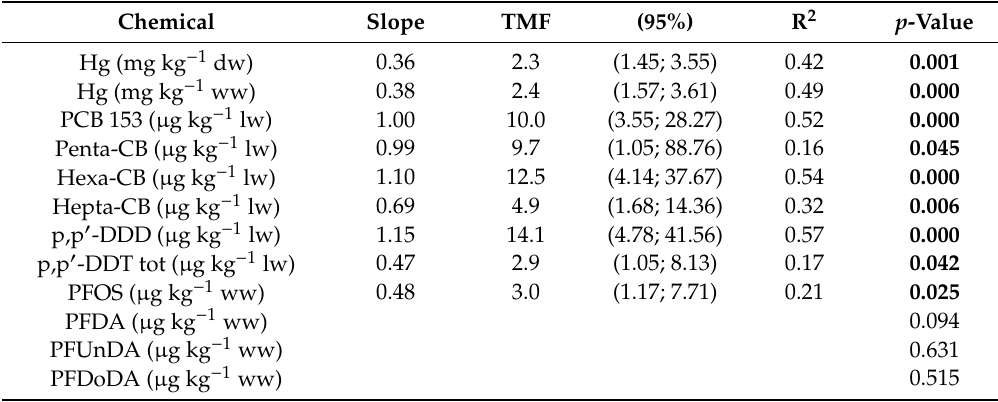
Table 2. Derivedtrophicmagnificationfactors(TMFs)ofselectedchemicalsforthelakefoodweb,